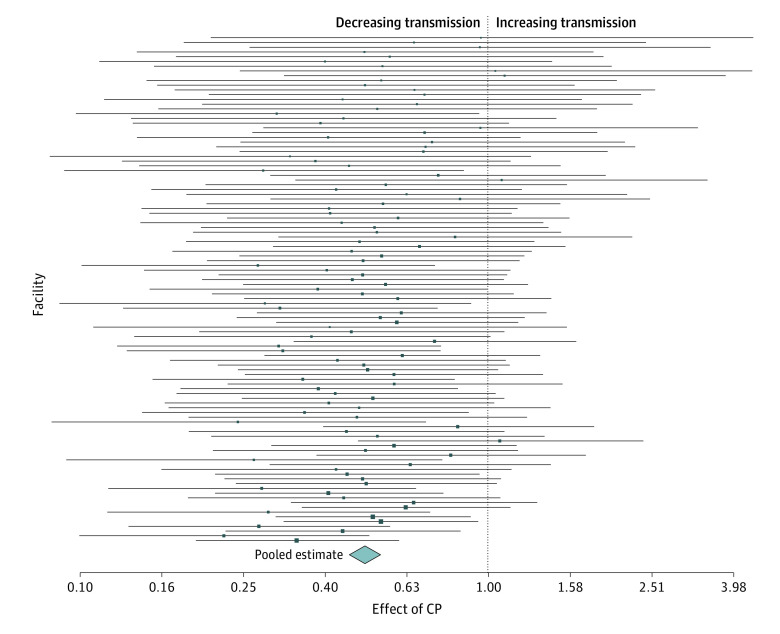
Facility-Specific Estimates From 2012 to 2013Forest plot showing the facility-specific estimates represented by squares, along with the corresponding 95% CIs for each of the facilities during the 2 years from 2012 to 2013. The pooled estimate is represented by the diamond at the bottom, with the width of the diamond indicating the 95% CI for the pooled estimate. The size of the squares reflects the precision of the facility-specific estimates. CP indicates contact precautions.